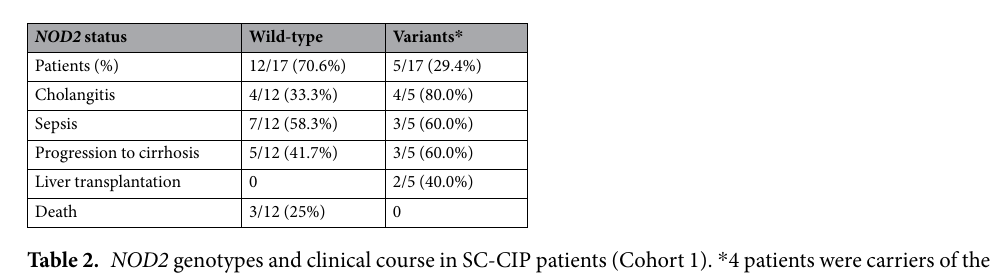
Table 2. NOD2 genotypes and clinical course in SC-CIP patients (Cohort 1). * 4 patients were carriers of the NOD2 variant p.R702W, and one patient carried the c.3020insC variant, all in heterozygous